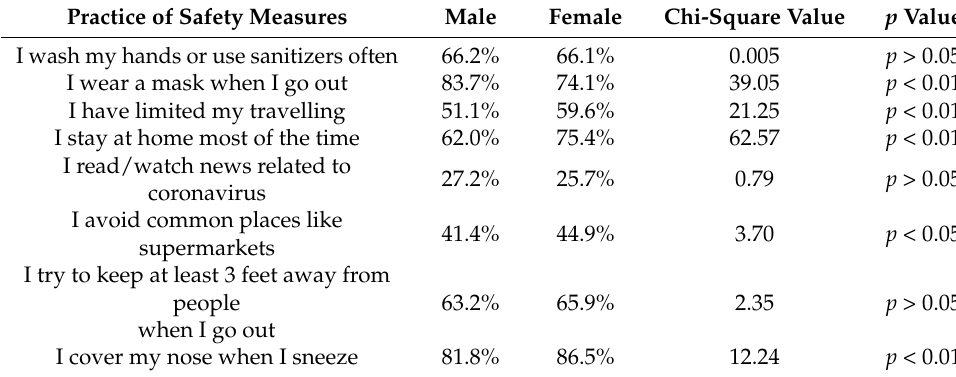
Table 1. Percentage of undergraduates who adhered to the safety measures of COVID-19 by gender ( n = 3044). Practice of Safety Measures